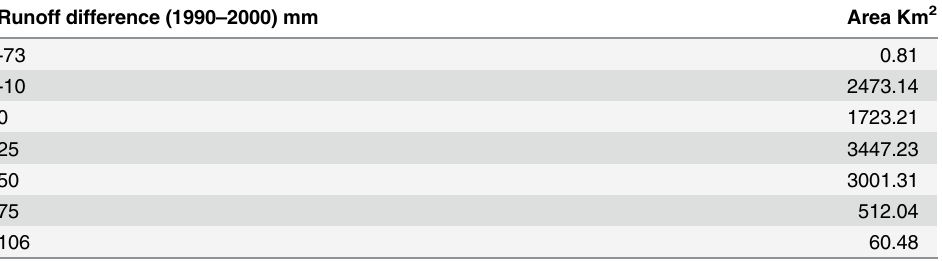
Table 5. The extent of the areas where surface runoff depth changes occurred with the study area (1990 –